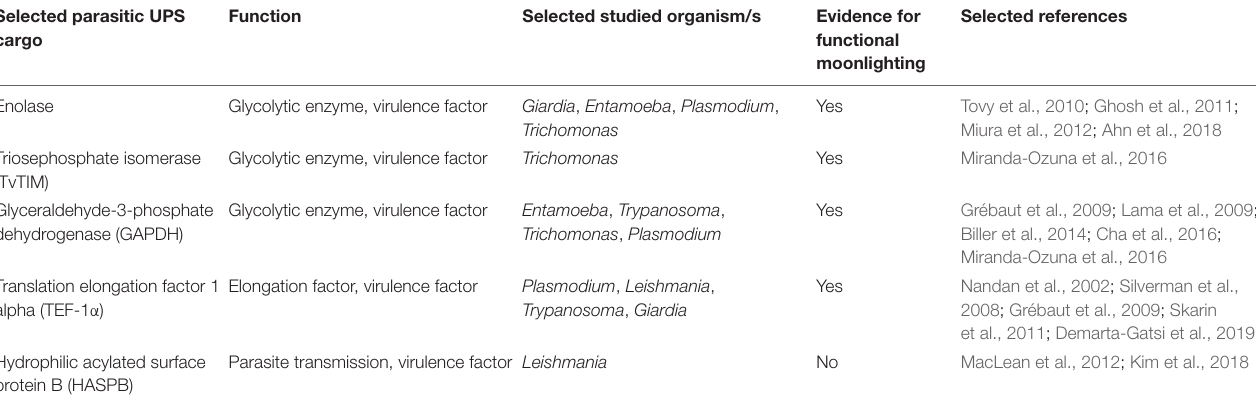
TABLE 2 | Overview of selected parasitic UPS cargo, including parasitic species and evidence for moonlighting functions. Selected parasitic UPS